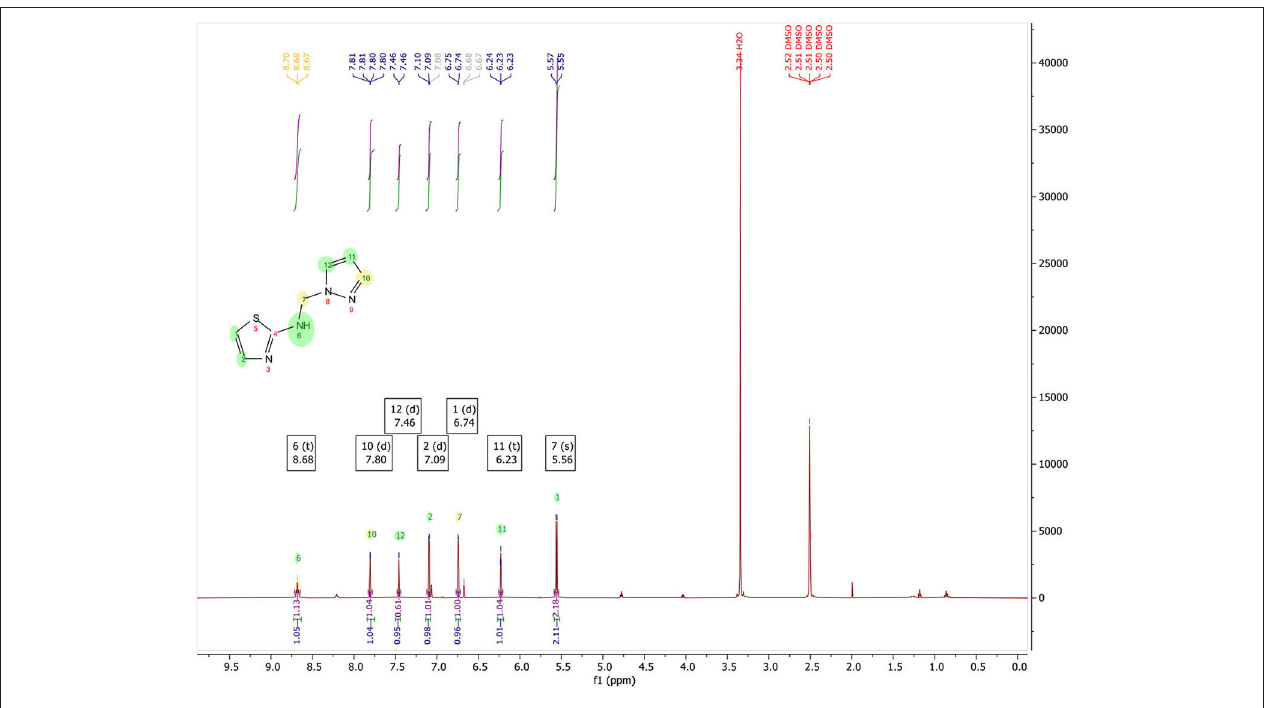
FIGURE 4 | 13 C NMR spectrum of N-((1H-pyrazol-1-yl)methyl)thiazol-2-amine, 7.